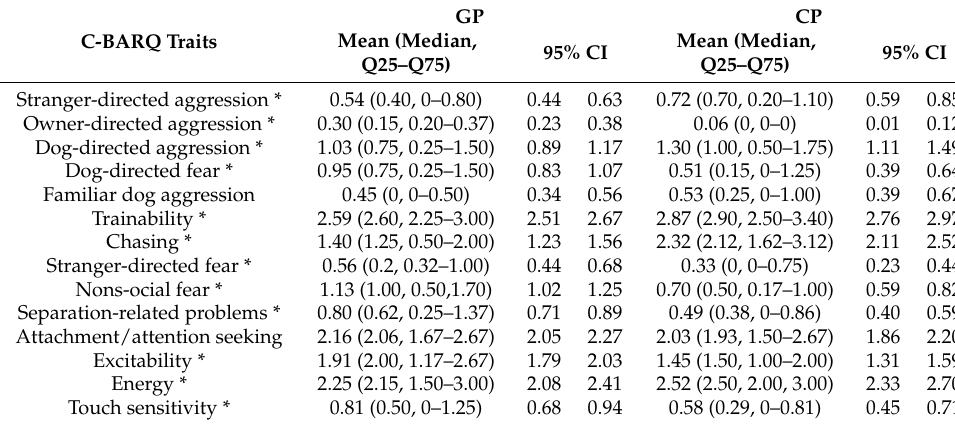
Abbreviations: C-BARQ = Canine Behavioural Assessment and Research Questionnaire; GP = general population; CP = Can de palleiro breed. * p < 0.05 when comparing GP and CP